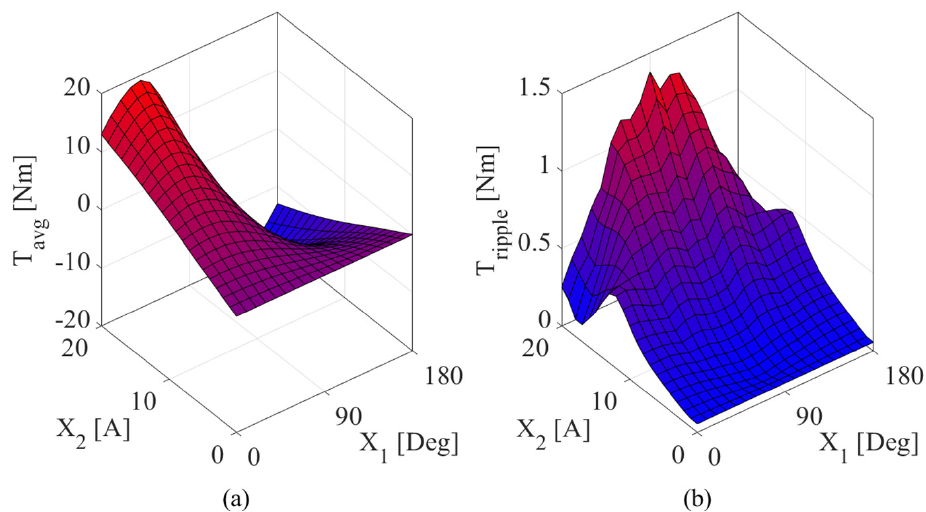
Figure 11. FEA results for torque performance of the Model-II: ( a ) Average Torque, and ( b ) Torque Ripple.